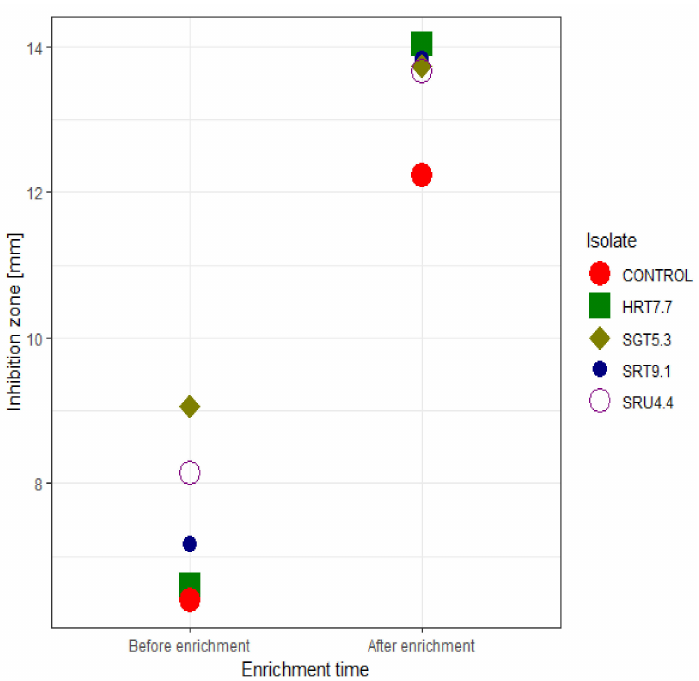
Figure 2. A scatter plot showing inhibition zones of the sweet pepper fruits isolates against the R. solanacearum BD 261 pathogenic strain, before and after